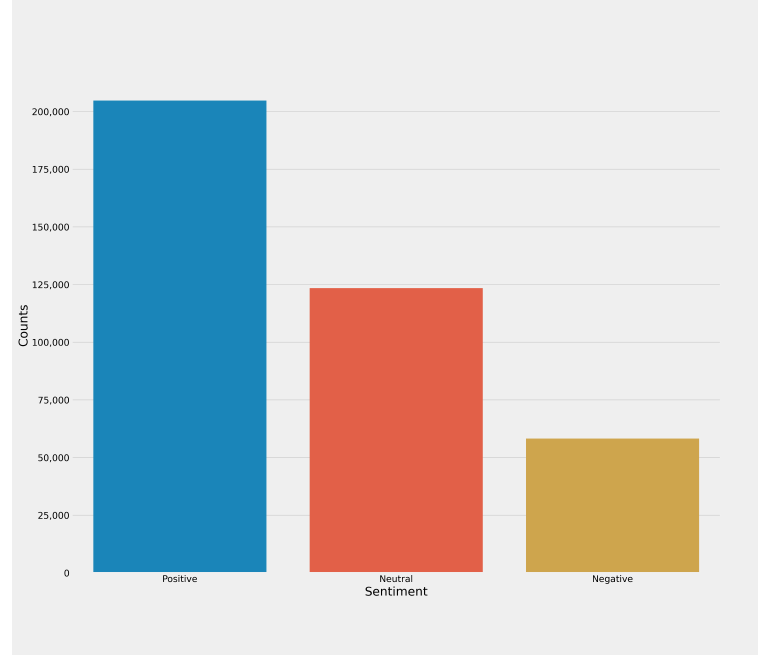
Figure 4. The distribution of positive, neutral and, negative sentiments.